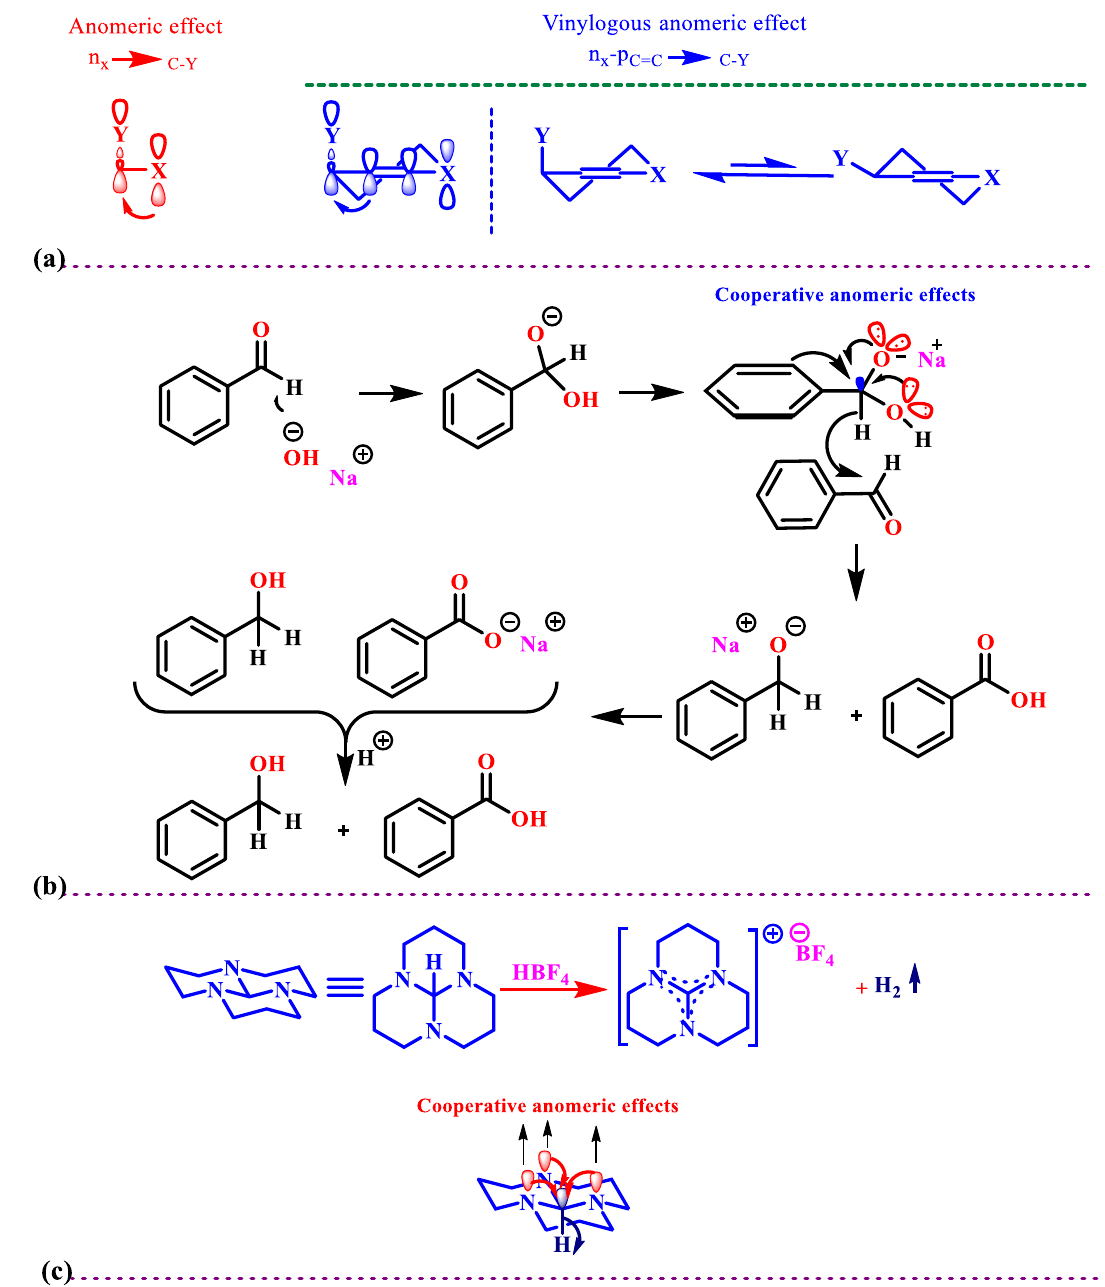
Figure 1. ( a ) Anomeric effect versus the vinylogous anomeric effect. ( b ) A (CABO) leads to hydride transfer in the mechanism of the Cannizzaro reaction. ( c ) Hydrogen releasing supported via a cooperative anomeric effect in the orthoformamide